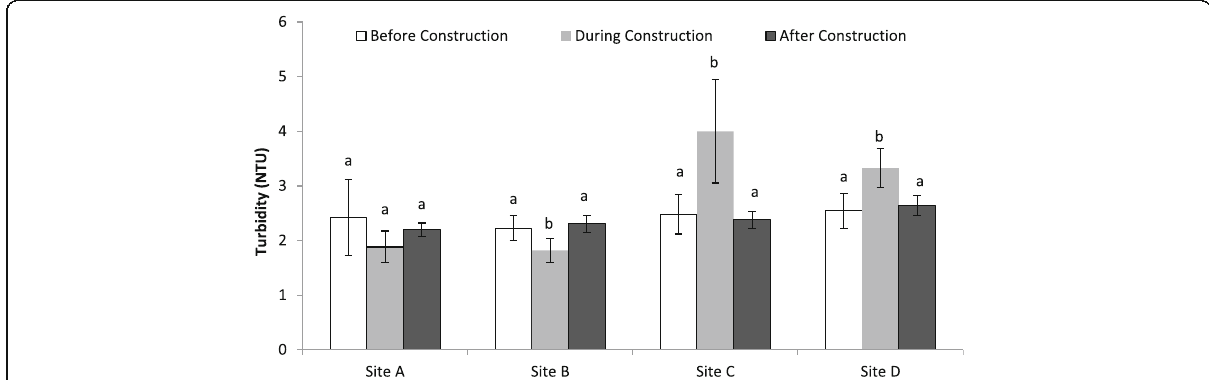
Fig. 2 Turbidity at the four sampling sites in the North Branch Park River. Bars indicate the mean ± 1 standard error (SE). The (a, b) markings above the columns indicate the groups identified with the Tukey test ( α =